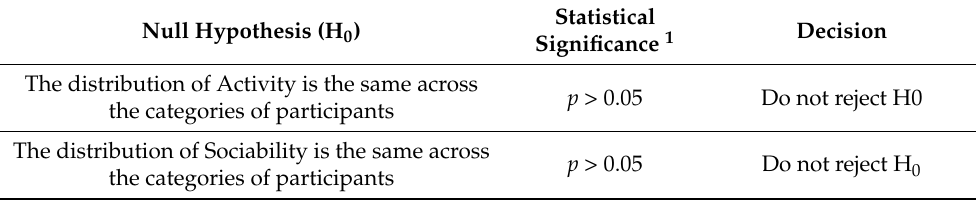
Table 4. Comparison of medians of psychological scores among participants that committed dumping and post-mortem burning as murder concealment acts, as well as those who did not commit